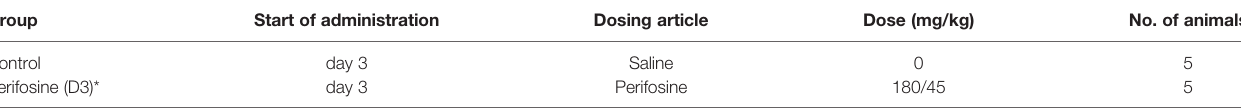
*180 mg/kg loading dose on day 3, followed by maintenance doses of 45